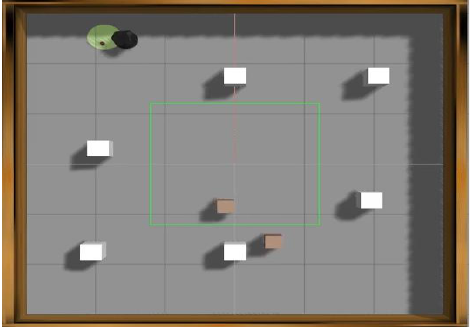
Figure 9. The mobile robot reached the target object once it is labeled using a DQN agent.